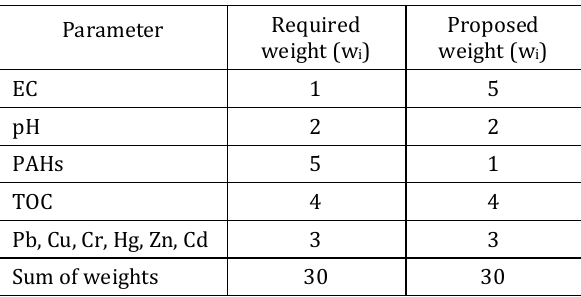
Table 1. Weights of parameters required to calculate